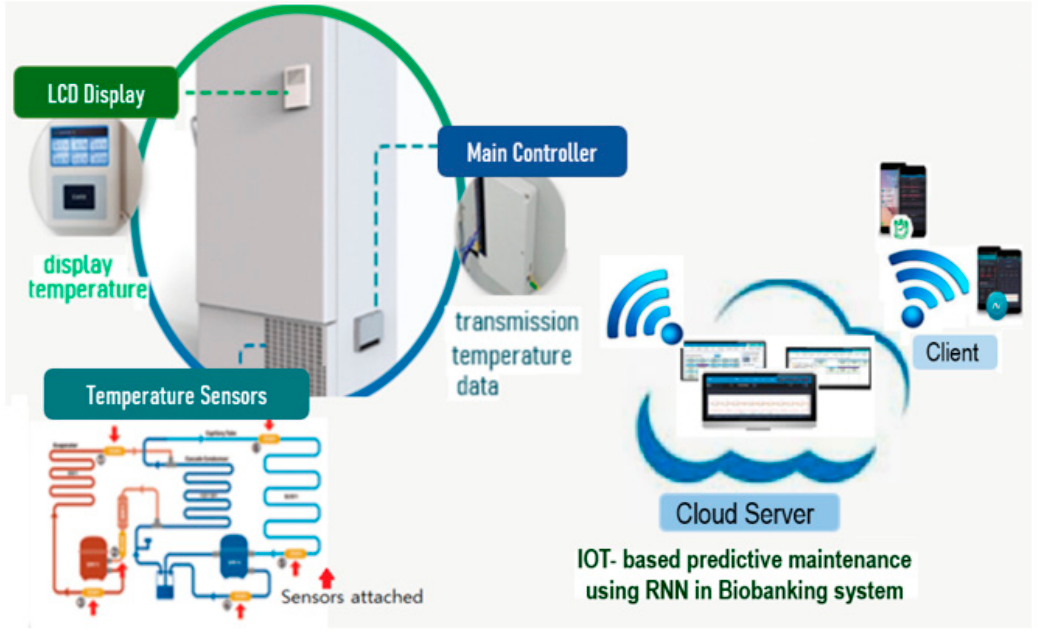
Figure 3. The framework of IoT-based intelligent monitoring system.